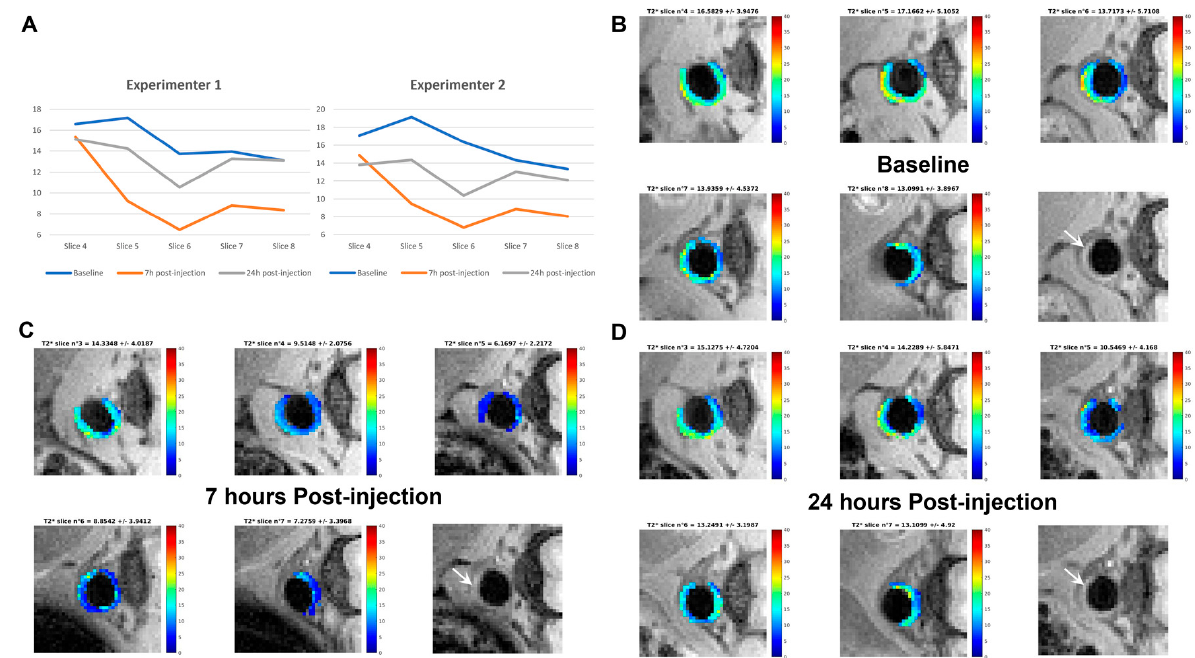
Figure 4. In vivo atheroma T 2 * variations after injection of NE-P3 (#5). ( A ): Diagrams made by two experimenters representing the T 2 * mean values (in ms) for each slice of the abdominal aorta of one Apoe − / − mouse at baseline, 7 h, and 24 h after NE-P3 (#5) injection. Typical segmented T 2 * maps of five slices before ( B ), 7 h ( C ), and 24 h ( D ) after NE-P3 (#5) injection, shown with the color scale. Slices 4, 5, 6, 7, and 8 before injection correspond to Slices 3, 4, 5, 6, and 7 after injection. After injection, great care was taken to reposition the mouse in exactly the same way as before injection; however, sections before and after injection could be shifted by one or two slices. The corresponding magnitude image (first echo) of the third slice in each dataset (i.e., Slice 6 at baseline and Slice 5 post-injection) is shown in the rightmost lower panel at each time point. In this image, the atheromatous plaque is clearly visible in white (arrow). Slice-by-slice T 2 * maps were obtained using a homemade MATLAB-based